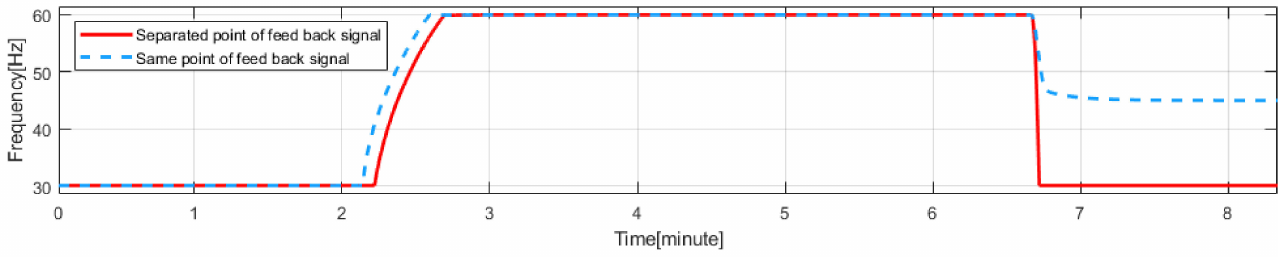
Figure 21. Comparing S.W. pump motor input